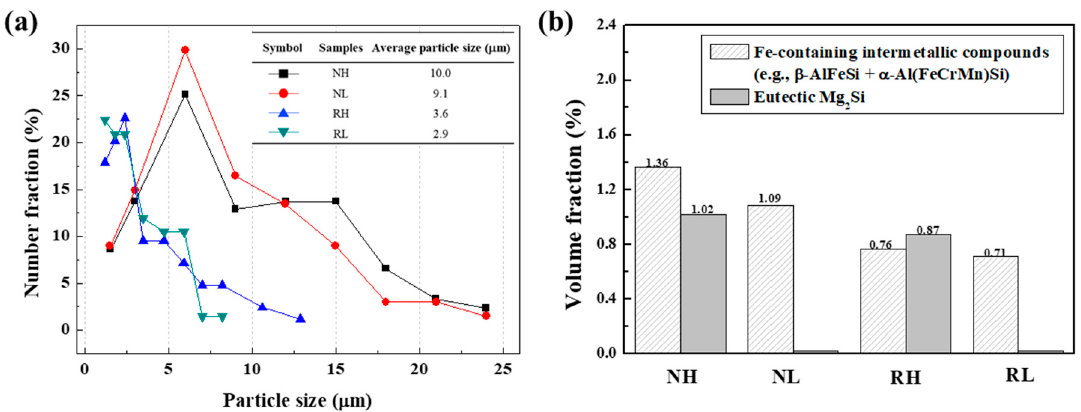
Figure 5. ( a ) Size distribution of the microscale particles in the NH, NL, RH, and RL alloys before cold rolling. The average sizes of the particles are interpolated in the figure. ( b ) Volume fractions of the Fe-containing intermetallic compounds and eutectic Mg 2 Si particles in the NH, NL, RH, and RL alloys before cold rolling.